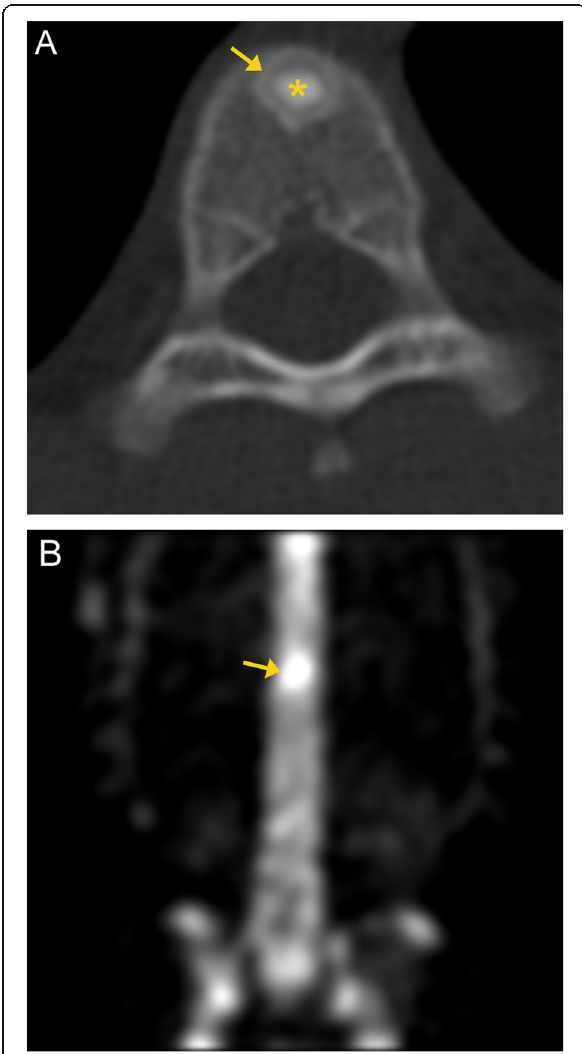
Fig. 6 Osteoid osteoma. Axial CT image ( a ) demonstrates a 1.2-cm sclerotic nidus (asterisk) at T10. The lesion is sharply demarcated with surrounding reactive sclerosis (arrow). Nuclear medicine bone scan ( b ) demonstrates focal intense uptake at T10 corresponding within the lesion